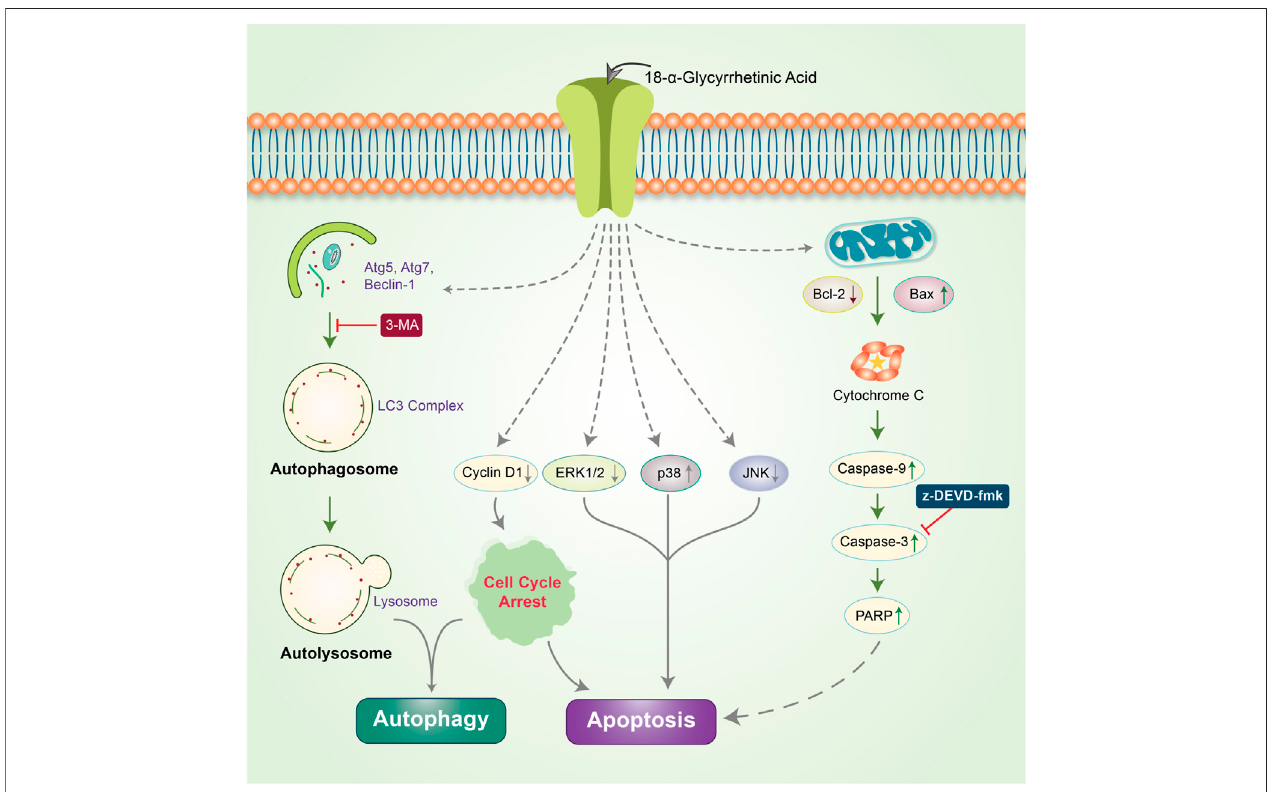
FIGURE 4 | Anticancer effects of 18-GA in autophagy-apoptosis modulation in neuroblastoma cells. 18-GA encouraged caspase-induced apoptosis by depolarizing the mitochondria membrane potential (MMP). 18-GA also induced early autophagy through Atg5 and Atg7 activation and converted LC3I to LC3II. The autophagy inhibitor, 3-MA, inhibited 18-GA-mediated autophagy. Nonetheless, 18-GA caused the downregulation of ERK1/2, JNK, and cyclinD1 protein and the upregulation of p38 MAPK, which activated apoptosis in neuroblastoma